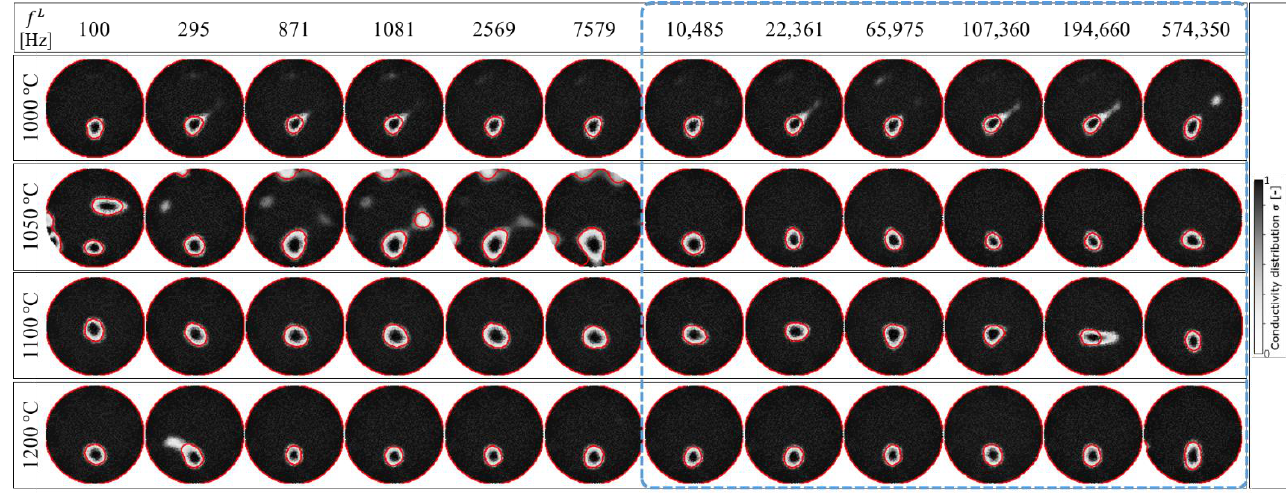
14 of 17 Figure 12. Image edge detection using the Chan-Vese segmentation algorithm. Figure 13. Image binarization. Finally, in step (3), the image reconstruction accuracy is defined as area error, ς f L , T , at the determined f H = 1,041,400 Hz in several f L , which is expressed as [36]: